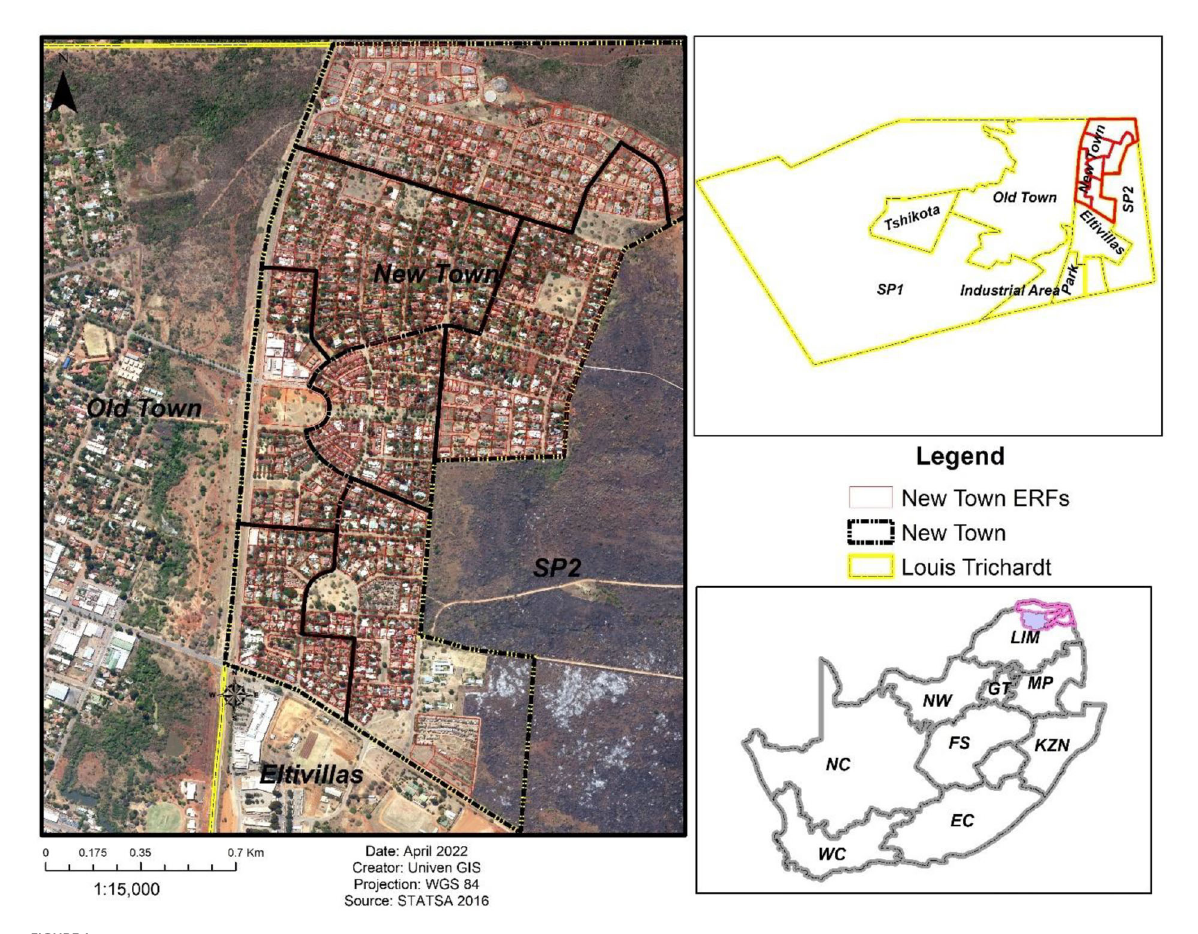
FIGURE1 Study location